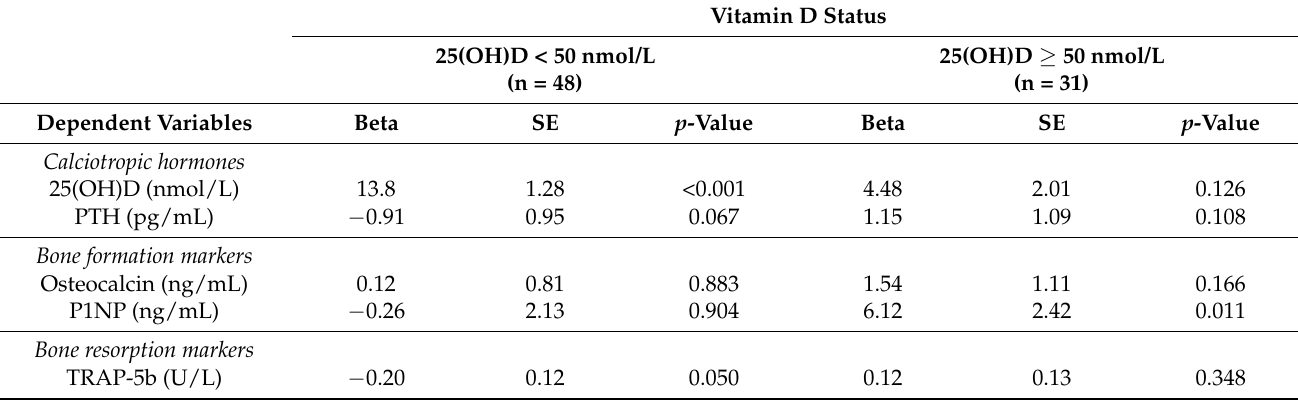
Table 2. Effect of the intervention with vitamin D-enriched cheese compared with the control group (independent variable) on serum concentrations of calciotropic hormones and bone resorption markers at follow-up (dependent variables), by vitamin D status at baseline.